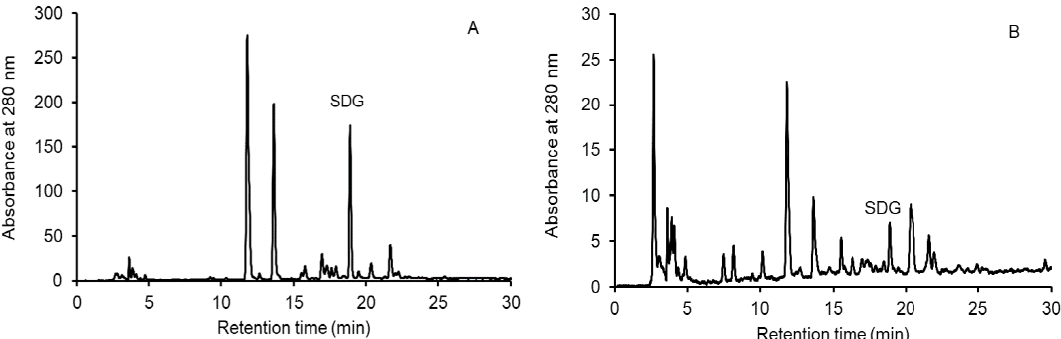
Figure 1. HPLC chromatograms showing SDG (t R 18.921) along with other components: ( A ) chro- matogram of the hydrolyzed FOCE; ( B ) chromatogram of the hydrolyzed FOCE100%. Table 2. Amount of SDG in the experimental GFBs with